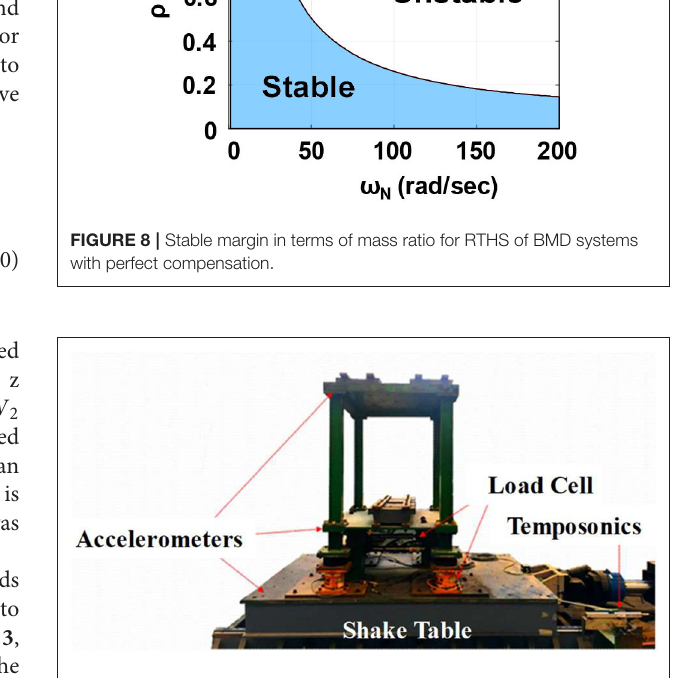
FIGURE 9 | Experimental setup of the experimental substructure of the simplified BMD